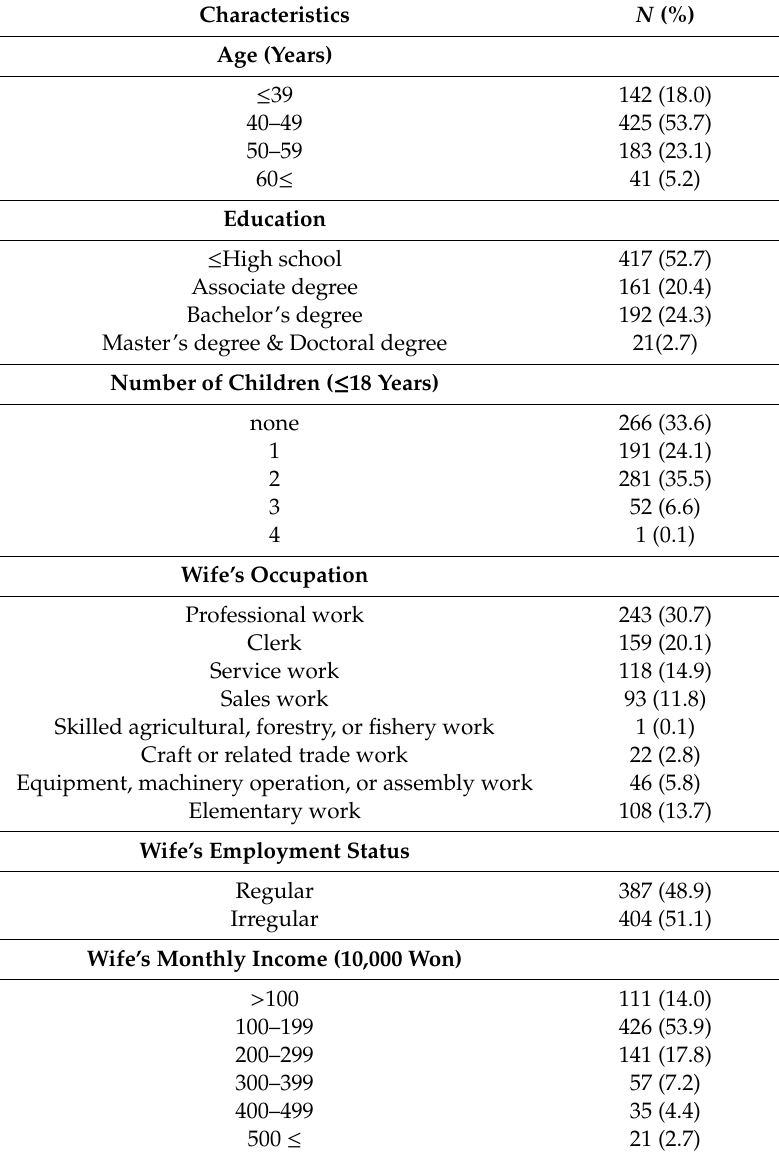
Table 1. General characteristics of participants ( n =